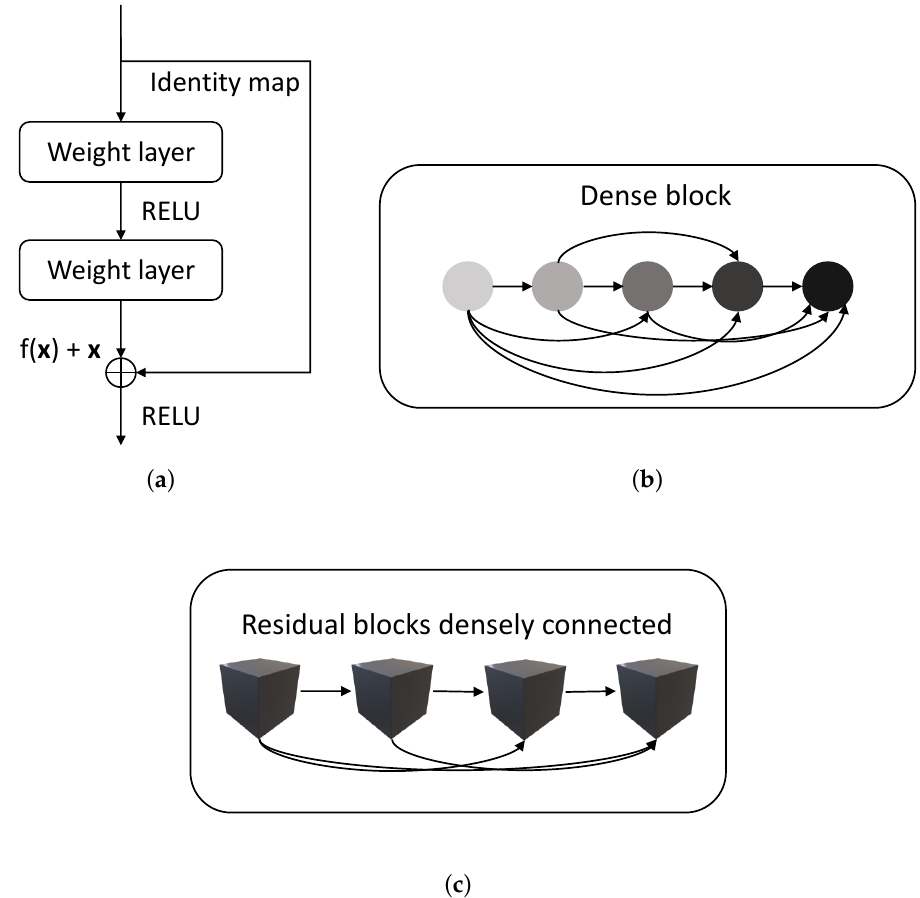
Figure 3. The modified connections of residual units showing each block are densely connected to previous blocks. ( a ) Residual block, ( b ) dense block, and ( c ) the modified residual blocks densely